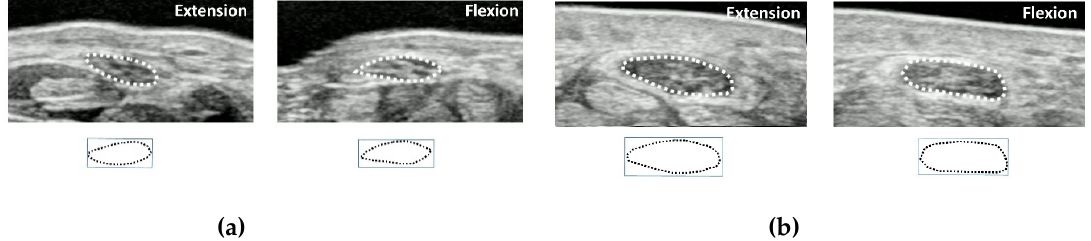
Figure 3. An example image of the median nerve shape in finger extension and flexion positions. ( a ) Healthy subjects, ( b ) carpal tunnel syndrome (CTS)patients. Reprinted from [48].